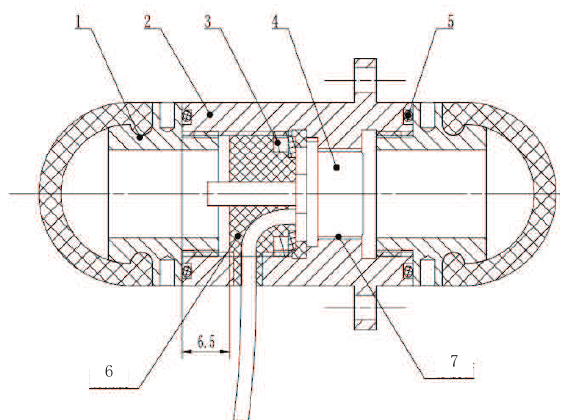
Figure 13. The schematic diagram of underwater UTFS assembly. (Note: 1. Flexible contact; 2. Sensor shell; 3. Snap ring; 4. Sensor core; 5. O sealing ring; 6. Epoxy Resin AB glue; 7. Glue filling cavity).